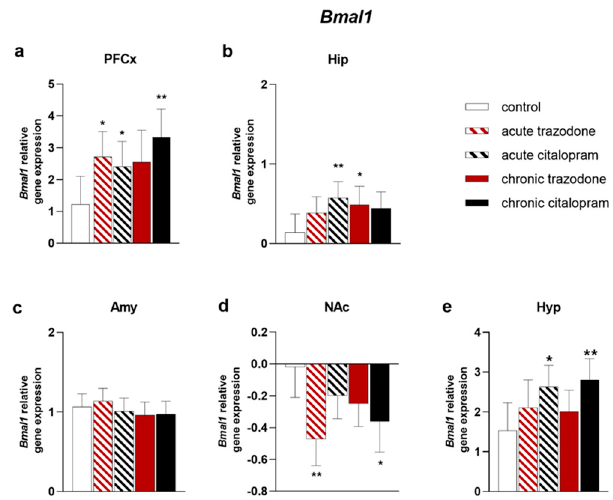
Figure 7. mRNA levels of Bmal1 in the PFCx ( a ), Hip ( b ), Amy ( c ), NAc ( d ), and Hyp ( e ) after acute or chronic treatment with trazodone, citalopram, or vehicle. The least square predicted means with 95% confidence intervals are plotted. Data were log-transformed when required to stabilise the variance and satisfy the parametric assumptions ( b , d ). **: p < 0.01; *: p < 0.05 in the Planned Comparison vs. control. n = 6/group.